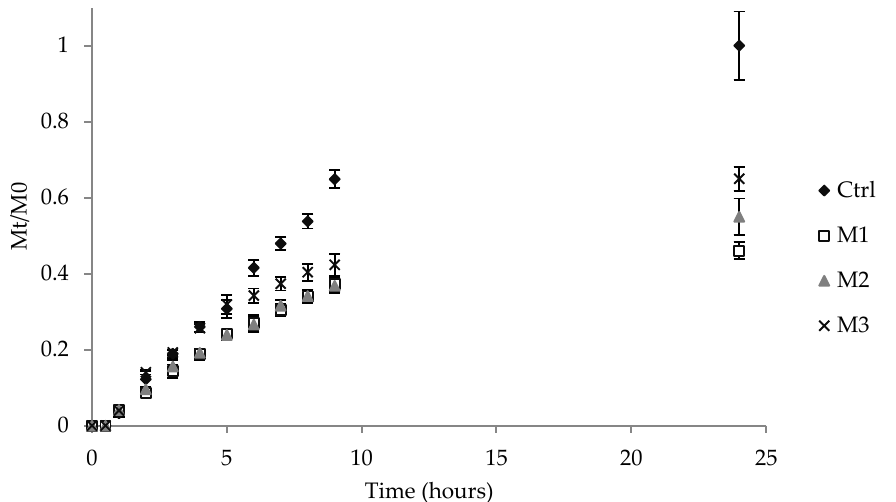
Figure 5. Cumulative drug amount (expressed as fractional amount Mt/M0, where Mt represents the amount of AZT released at each time and M0 the total AZT mass) released from microemulsions and control (Ctrl) plotted as a function of time. Data are expressed as means ± SD, n = 3.